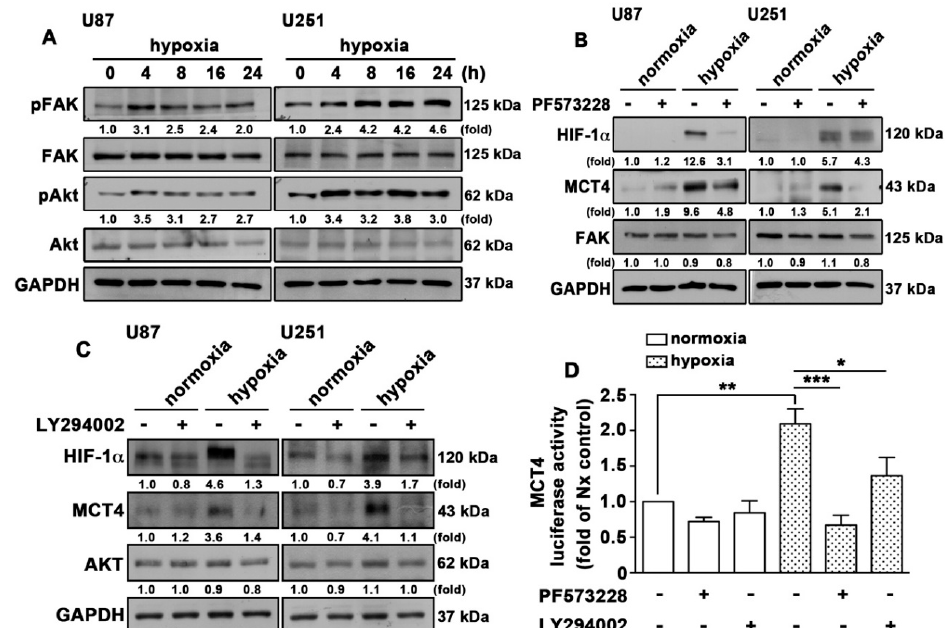
Figure 7. Activation of FAK and AKT is involved in the hypoxia-induced HIF-1 α and MCT4 expression in GBM. ( A ) U87 and U251 cells were exposed to hypoxic conditions (1% O 2 ) for indicated time periods (4, 8, 16 or 24 h), and expression of p-FAK (Tyr397) and p-AKT (Ser473) was determined using western blotting. ( B ) U87 (left panel) and U251 (right panel) cells were treated with PF573228 (2 µ M) for 30 min and were exposed to hypoxic conditions (1% O 2 ) for another 24 h. FAK, HIF-1 α , and MCT4 expression was determined using western blotting. ( C ) U87 (left panel) and U251 (right panel) cells were treated with LY294002 (10 µ M) for 30 min and were exposed to hypoxic conditions (1% O 2 ) for another 24 h. AKT, HIF-1 α , and MCT4 expression was determined using western blotting. ( D ) U251 cells were transfected with MCT4 luciferase reporter plasmids for 24 h and were treated with PF573228 (2 µ M) or LY294002 (10 µ M) for 30 min and were then exposed to hypoxic conditions (1% O 2 ) for another 24 h. Firefly luciferase activity was measured, and the results were normalized to renilla luciferase activity. Two-way ANOVA with a post-hoc Bonferroni test was used to examine the significance of the mean. * p < 0.05 compared with the hypoxia-only group. ** p < 0.01 compared with the normoxia control group. *** p < 0.001 compared with the hypoxia-only group. Quantitative data are presented as the mean ± S.E.M. ( n =